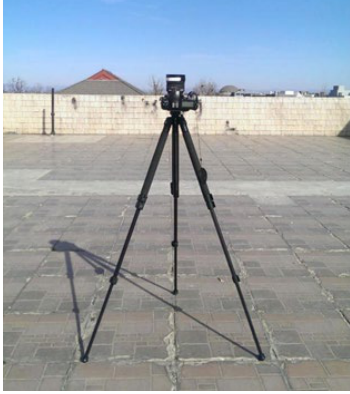
Figure 1. Fish eye camera for polarization